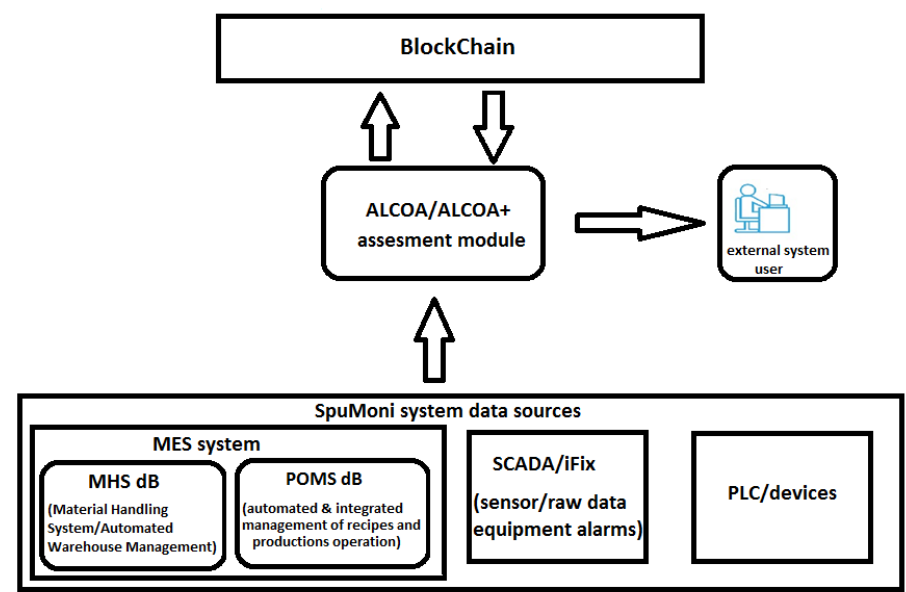
Figure 1. SPuMoNI’s RegTech architecture .